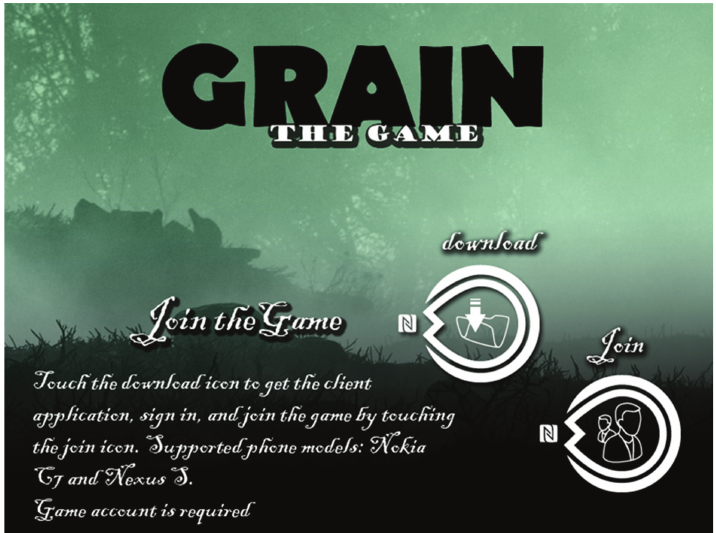
Figure 9: A service advertisement for downloading and joining a game shown on a wall